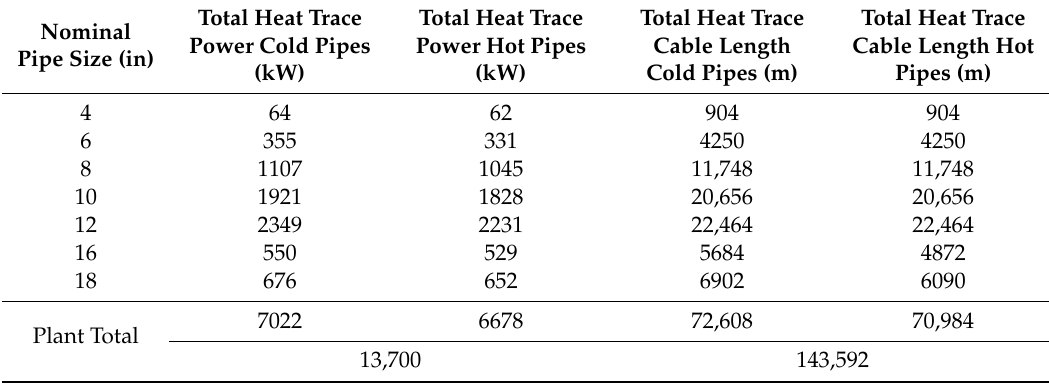
Table 2. Plant heat trace specifications for a HiTec XL-based plant with 388 collector loops.